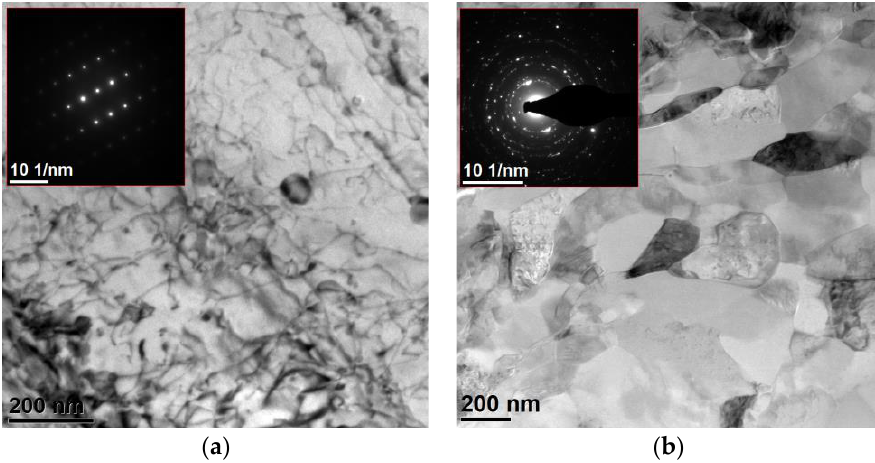
Figure 10. TEM images of ( a ) monocrystalline ( b ) polycrystalline areas in the aluminium alloy matrix.